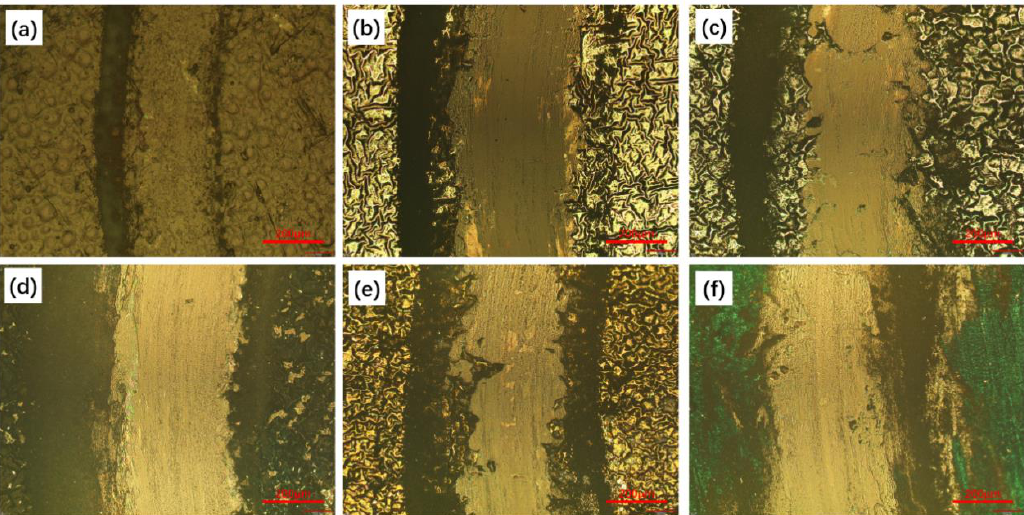
Figure 9. Optical images of wear tracks of ( a ) PMMA, ( b ) Ti/PMMA, and the films prepared on Ti/PMMA at different substrate bias of ( c ) 350 V, ( d ) 550 V, ( e ) 750 V, and ( f ) 950 V without conduc- tive material.